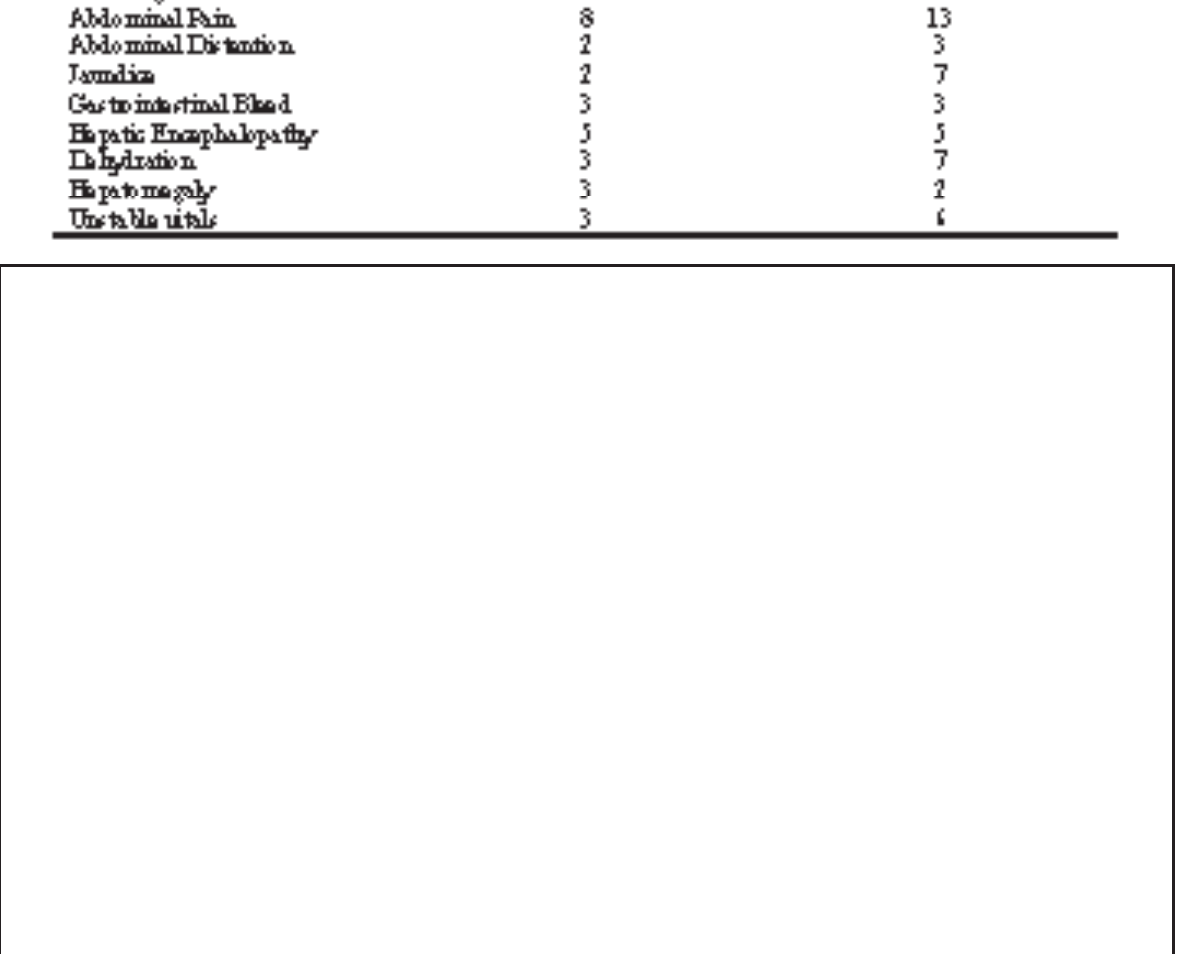
Fig.2: Amanita Mushrooms are large mushrooms with slender stipe and a cap with brown, green or reddish colours. The under surface of the cap is covered by white lamella (like pages in a book)